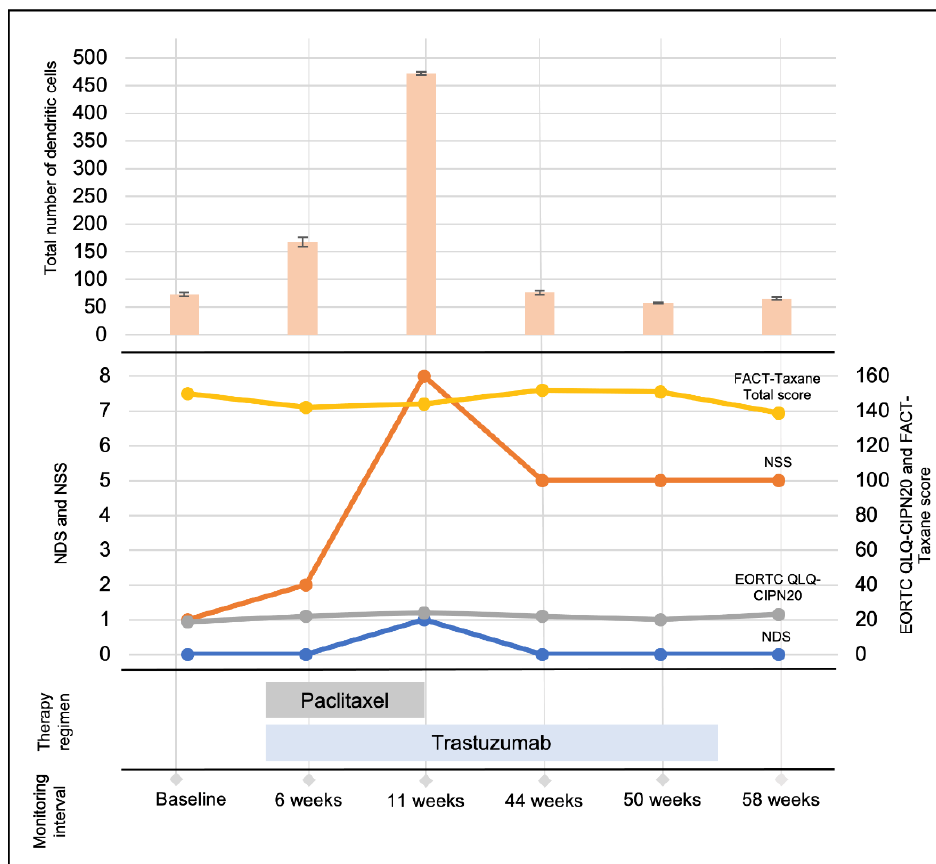
Figure 2. Total dendritic cell (DC) count within identical corneal areas, nerve function testing score, and questionnaires outcome of a breast cancer patient (human epidermal growth factor receptor (HER)-2-positive) in the course of paclitaxel and trastuzumab breast cancer therapy regimen and monitoring intervals. Total number of dendritic cells: Total DC count within identical areas of the corneal subbasal nerve plexus before therapy at baseline, during therapy (6, 11, 44, and 50 weeks